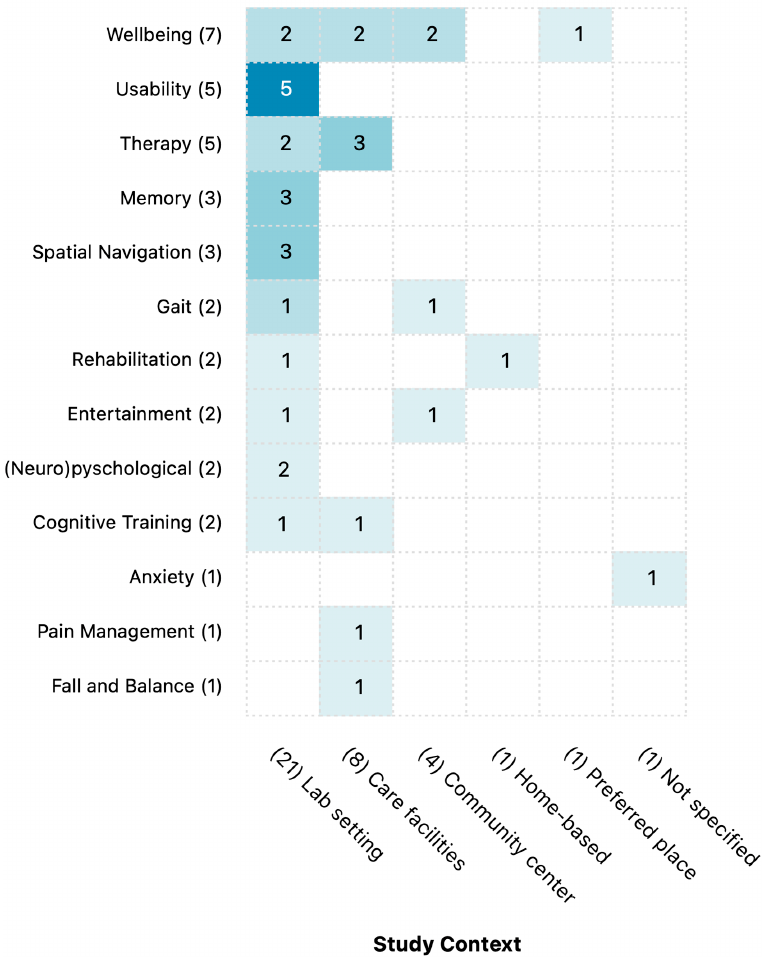
Figure 2. Studies classified based on objective and